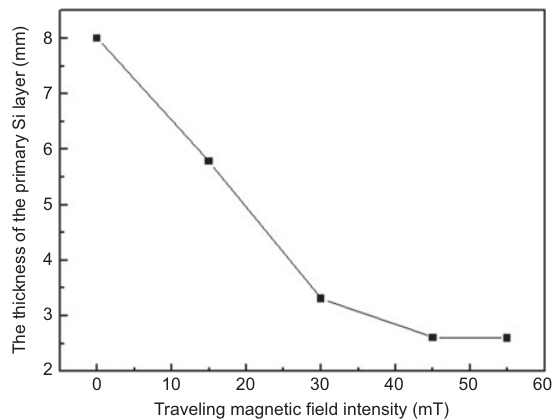
Figure 5 The principle of the electromagnetic separation method.